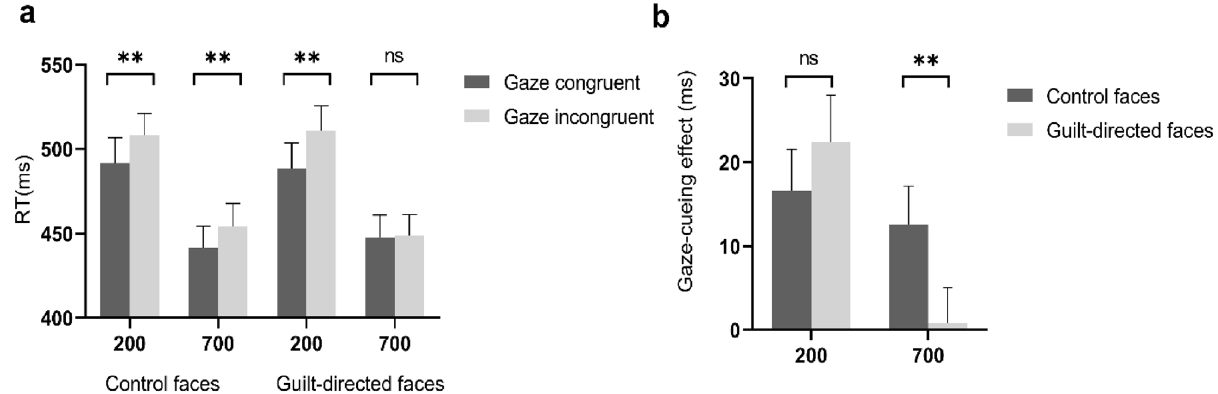
Figure 2. Interactions between face type, SOA and gaze congruency. The left panel ( a ) shows the three-way interaction between face type, SOA and gaze congruency. The right panel ( b ) shows the two-way interaction between SOA and face type. RT = reaction time. Gaze-cueing effect = RT incongruent gaze − RT congruent gaze ). * p < 0.05, ** p < 0.01, *** p < 0.001, ns non significance. Bars depict M ± SE .